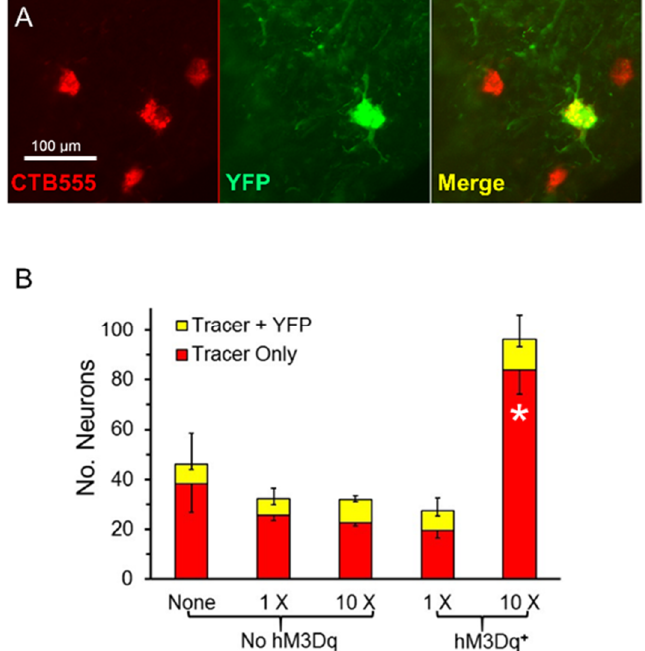
Figure 3. ( A ) Examples of singly and doubly labeled motoneurons in the spinal cord (40×). ( B ) Mean number of retrogradely labeled neurons four weeks after sciatic nerve transection and repair. The red portion of each bar represents the numbers of neurons containing only the retrograde fluorescent tracer used; the yellow portion the number of cells containing both the tracer and YFP. Positive error bars are the SEM ( N = 4) for total motoneuron (tracer + tracer and YFP) numbers; downward error bars tracer only and tracer + YFP groups. * = p < 0.05 vs. all other groups.